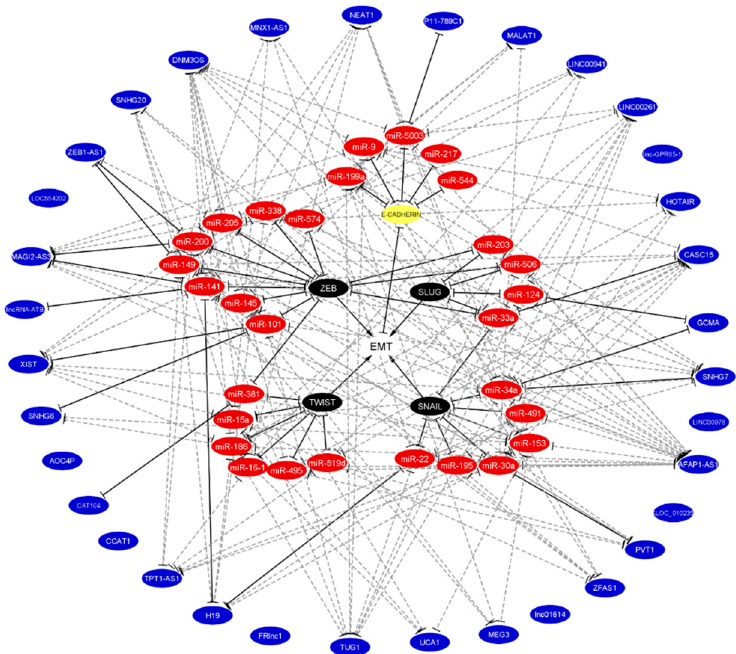
Figure 4. Integration of predicted and validated non-coding RNA that regulates EMT the binding with E-cadherin and EMT-TFs. Validated miRNA, lncRNA, and ceRNA networks were taken from literature according to Figure 3. Predicted miRNA, lncRNA, and ceRNA networks were predicted by the miRwalk 2.0 database. The white circle denotes EMT, the yellow circle denotes E-cadherin, black circles denote EMT-TFs, red circles denote miRNAs, and blue circles denote lncRNAs. Validated bindings are shown in solid black lines, while predicted bindings are shown in gray dotted lines. The lack of lines in blue circles denotes that no predictions were found. Of note, the chemoresistant miRNAs (miR-15a-3p, miR-16-1-3p, miR-34a, miR-141, miR-145, and miR-200) participate in these networks.